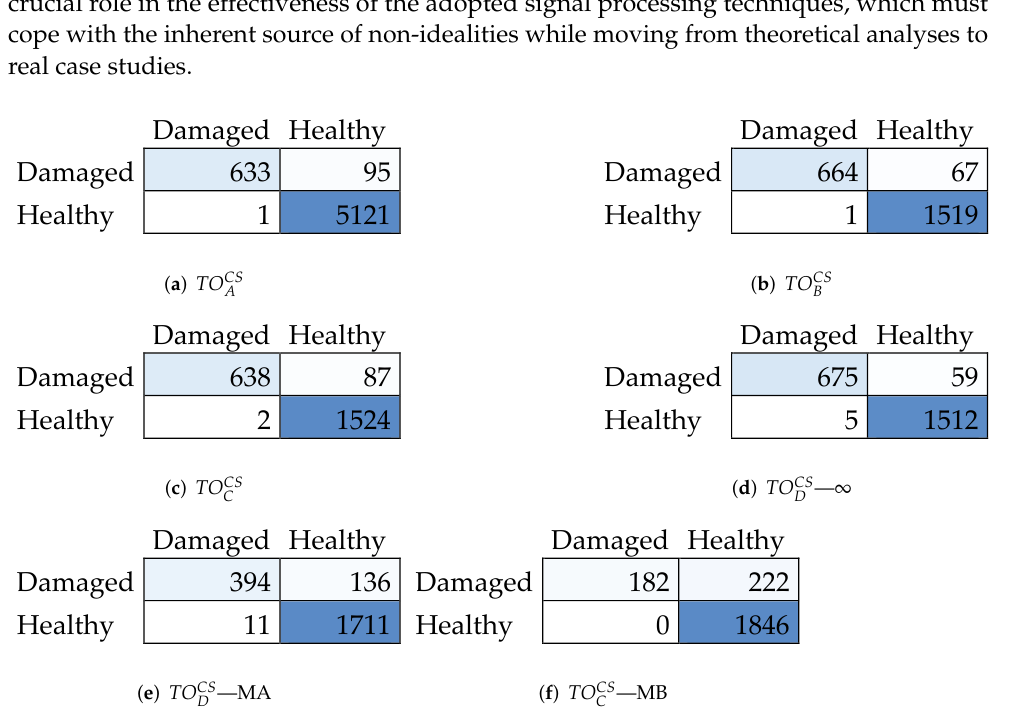
Figure 9. Confusion matrices corresponding to the classification scores presented in Table